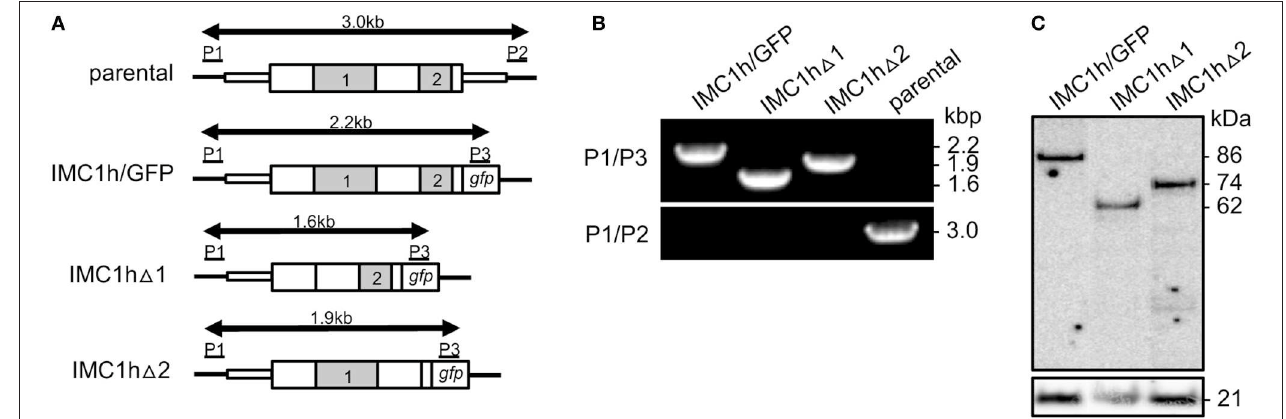
FIGURE 1 | Generation and genotyping of IMC1h mutants. (A) Schematic diagram of the parental and modified imc1h alleles. The imc1h gene is indicated with coding sequence (wide bars) and 5 ′ and 3 ′ untranslated regions (narrow bars). The relative positions of domains 1 and 2 are indicated (gray). Also shown are the gfp module, positions of primers P1–P3 used for diagnostic PCR amplification, and the predicted lengths of the amplicons (arrows). (B) PCR with primers P1 and P3 diagnostic for integration of the modified, GFP-tagged imc1h alleles into the imc1h locus, or with primers P1 and P2 diagnostic for absence/presence of the unmodified parental imc1h allele. Amplicon sizes (kb) are indicated on the right-hand side and correspond to those depicted in (A) . (C) Western blot analysis of purified ookinetes ( ∼ 50,000 per lane) of IMC1h mutant parasite lines using anti-GFP antibodies, showing successful expression of IMC1h::GFP fusion proteins. Identified band sizes reflect the introduced domain deletions in IMC1h, resulting in proteins of 86 kDa (IMC1h/GFP), 62 kDa (IMC1h 1 1), and 74 kDa (IMC1h 1 2). The ookinete surface protein Pbs21 is shown as a loading